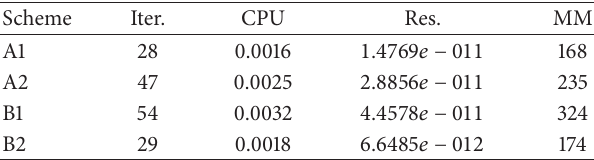
Table 4: Numerical results of Example